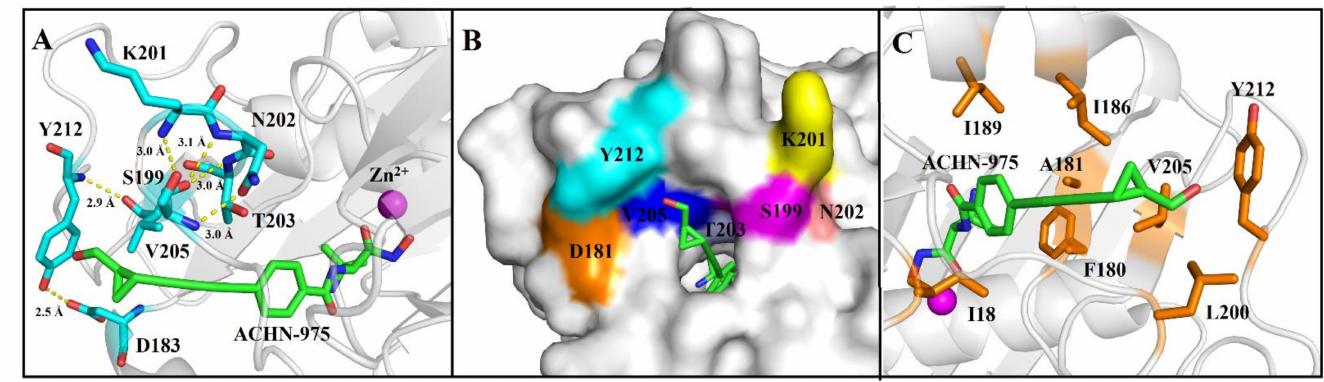
Figure 5. Close-up views of ACHN-975 with surrounding residues. ( A ) The models of the amino acids of S199, Y212 and their surroundings. The dotted lines indicate a hydrogen-bonding network around the residues at the position 199 and 212. ( B ) A view of the ACHN-975 binding onto AaLpxC. Highlighted in surface view are amino acids involved in shaping the substrate pocket. ACHN-975 (white), D181 (oranges), S199 (magentas), K201 (yellow), N202 (salmon), T203 (lightblue), and V205 (blue). ( C ) Close-up views of ACHN-975 with surrounding aliphatic residues. The ACHN-975 and surrounding residues are indicated as stick models. The Zn 2+ -ion is depicted as a magenta